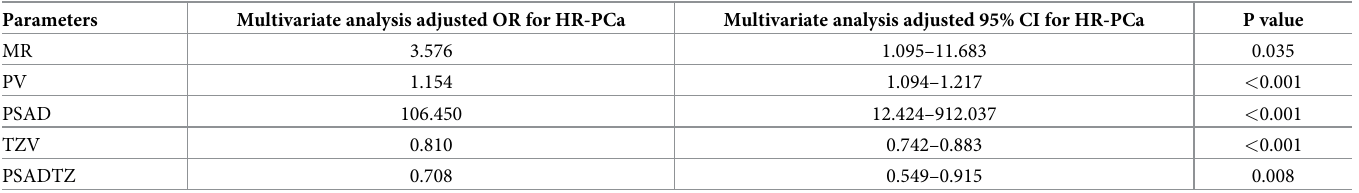
Table 4. Multivariate logistic regression analysis of predictors associated with HR-PCa at the initial biopsy (backward elimination selection procedure).